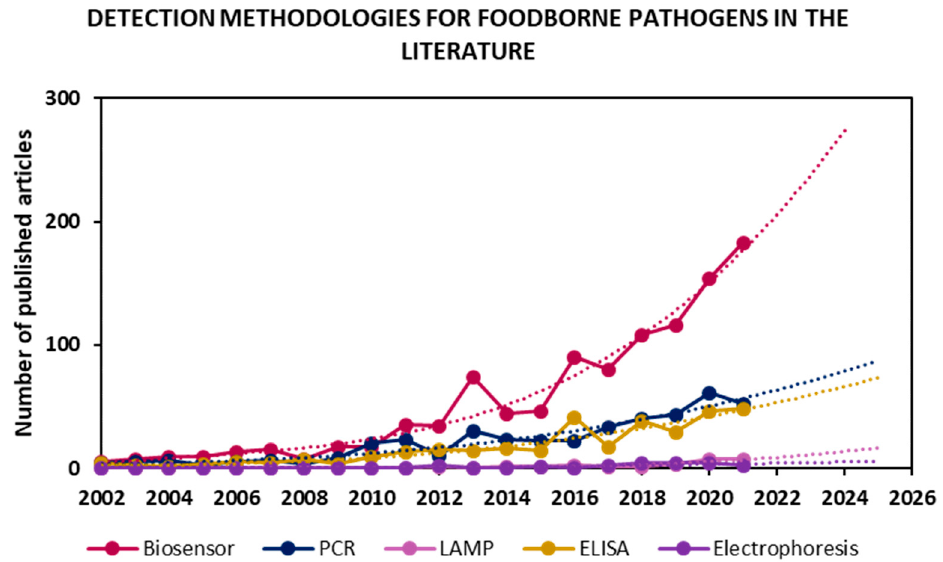
Figure 1. Detection methodologies for foodborne pathogen detection in the literature in the period of 2002–2021. Values were obtained by searching “foodborne pathogen detection” and synonyms as keywords in Scopus, then classifying 2424 articles found in the literature by methodologies. Trends obtained by fitting a tendency curve and projecting it for the next 4 years.